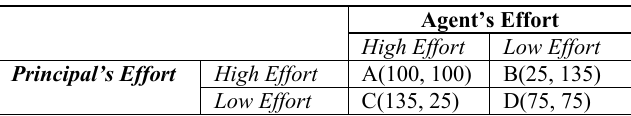
Table 1: Utility matrix of a principal and an